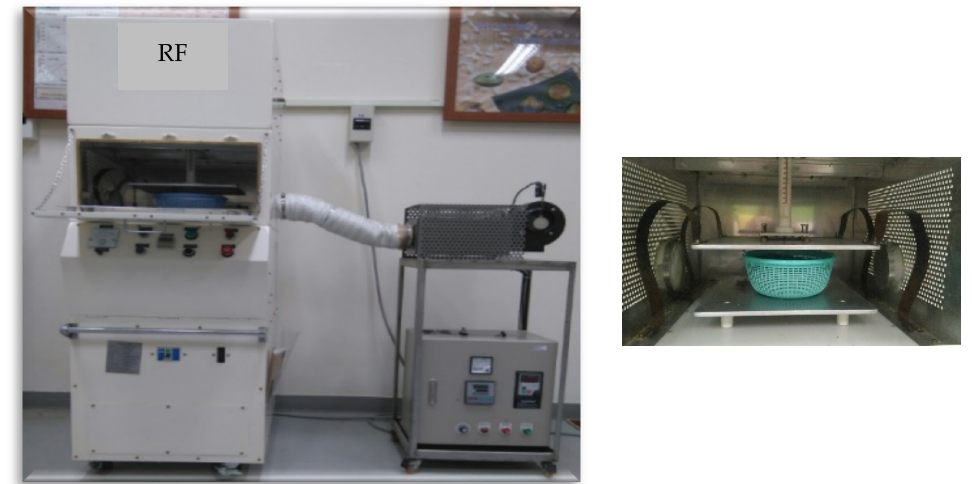
Figure 1. 5 kW, 40.68 MHz RF hot air equipment ( left ) and a sample basket placed between RF electrodes ( right ).